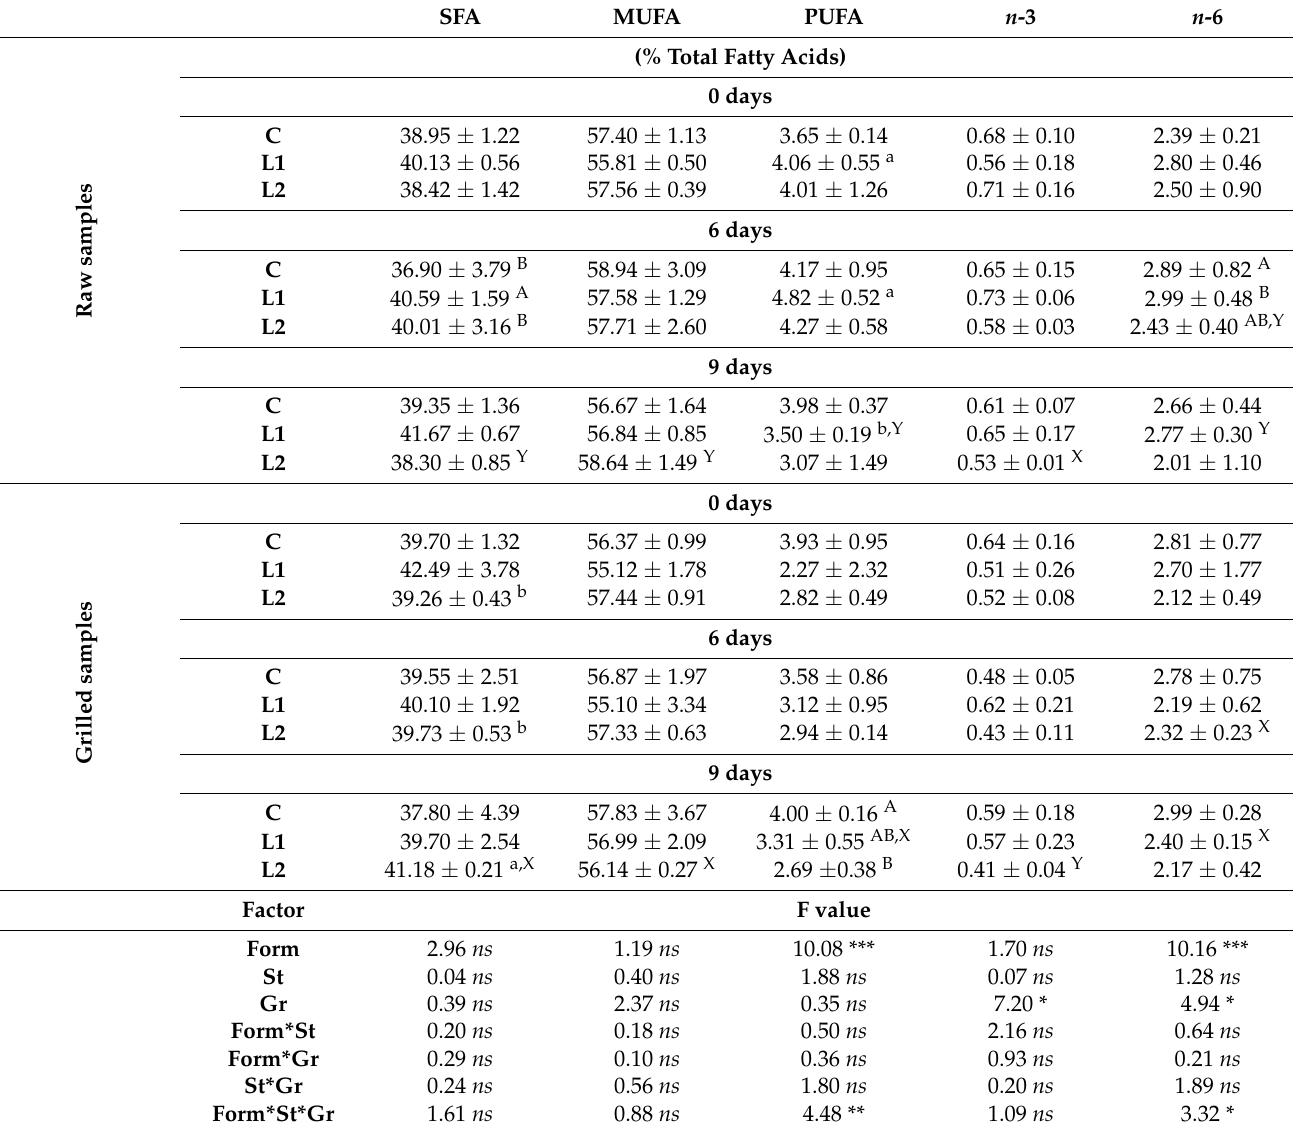
Table 4. Fatty acid classes (expressed as % of total fatty acids) of raw and grilled hamburgers after 0, 6 and 9 days of storage. C, Control (minced beef meat + maltodextrine + starter cultures); L1, minced beef meat + starter